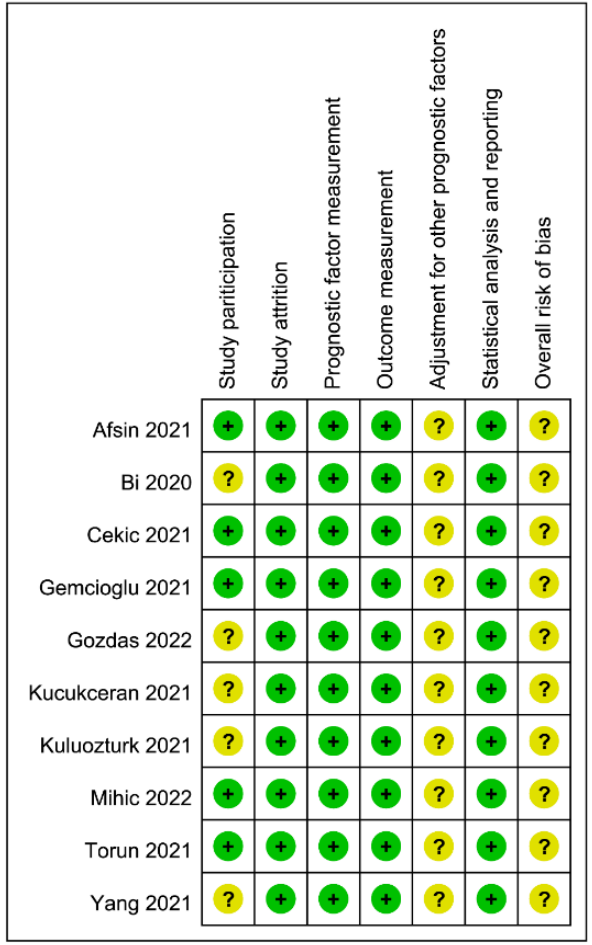
Figure 2. Risks of bias based on assessment with the Quality in Prognostic Studies (QUIPS) tool [12,24,25,32–38].